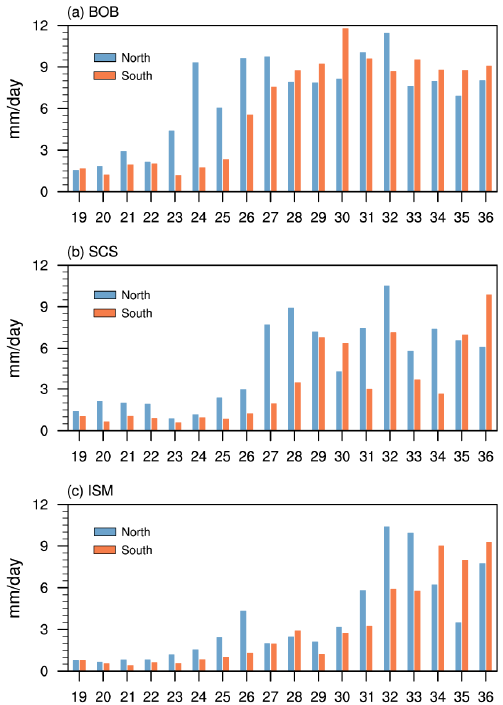
Figure 9. Composite rainfall over ( a ) the BOB (5°–15° N, 90°–100° E), ( b ) SCS (10°–20° N, 110°–120° E) and ( c ) ISM (10°–20° N, 70°–85° E) from Pentad 19 to Pentad 36 in the Northward (blue bars) and Southward (orange bars) shift cases (mm/day).